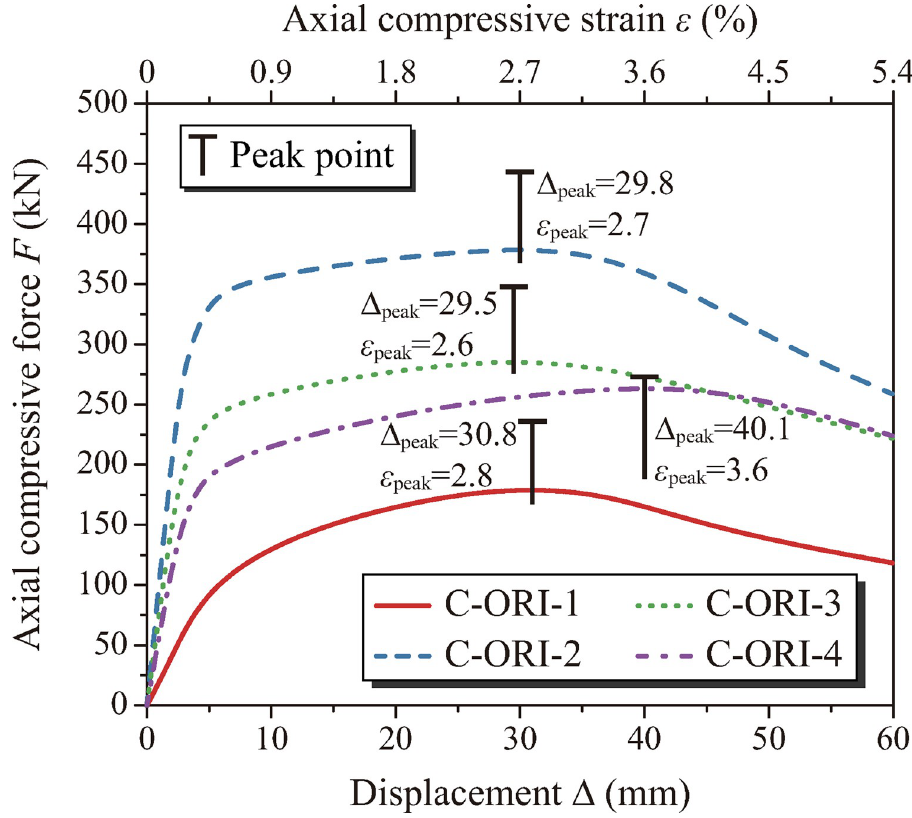
Fig 9. Load force F versus load displacement Δ